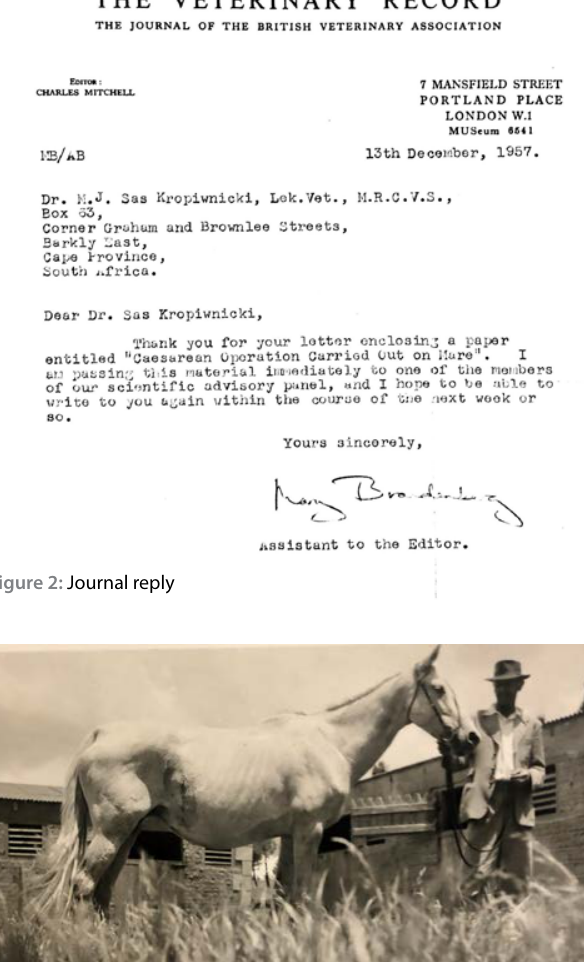
Figure 3: Smart girl